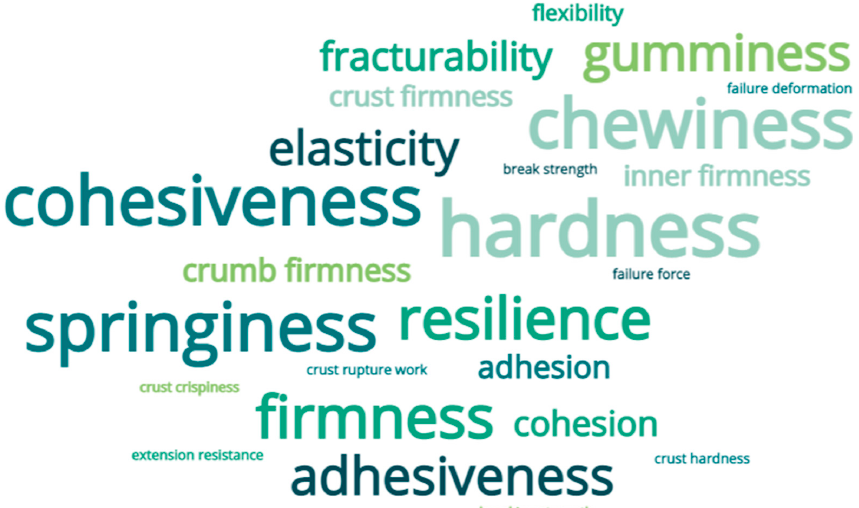
Figure 7. Word cloud for the properties analyzed through sensorial analysis in bakery products.